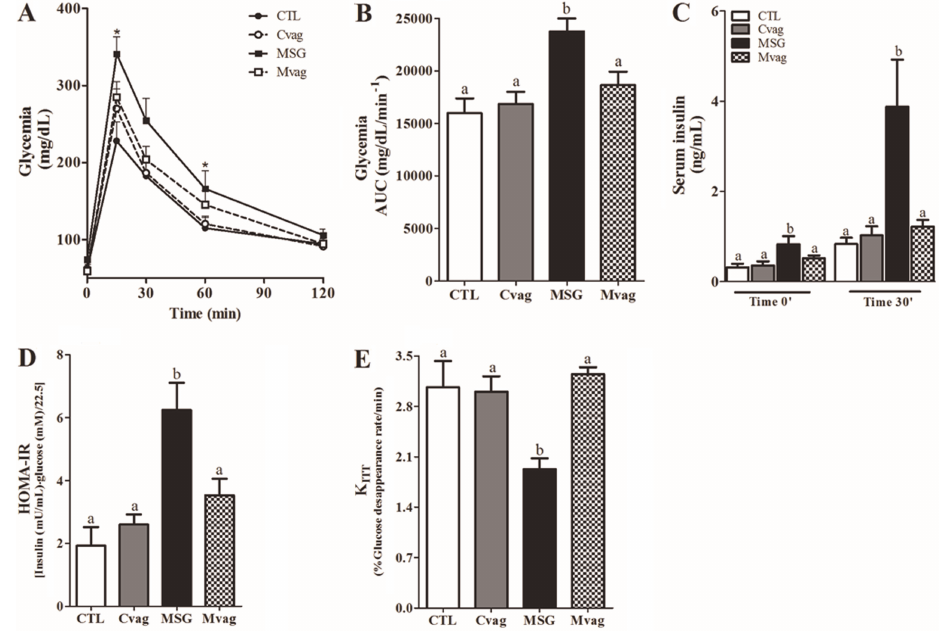
Figure 2. A , Changes in blood glucose during the intraperitoneal glucose tolerance test ( ip GTT) in 90-day-old CTL, Cvag, MSG and Mvag rats. B , Total plasma glucose concentrations during the ip GTT, reported as the AUC. C , Insulinemia at 0 and 30 min of the ip GTT. Insulin sensitivity measured by HOMA-IR ( D ) and K ITT ( E ). CTL: control; Cvag: CTL with subdiaphragmatic vagotomy; MSG: monosodium glutamate; Mvag: MSG with subdiaphragmatic vagotomy; AUC: area under the curve; HOMA-IR: homeostasis model assessment index; K ITT : glucose disappearance rate. Data are reported as means±SE obtained from 8 rats for each group. *Significant difference between MSG and CTL. Different letters indicate statistically significant differences (two-way ANOVA followed by Duncan’s post-test, P #